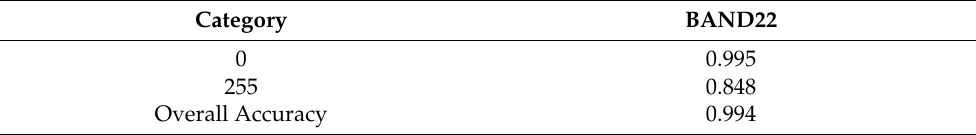
Table 17. Quantitative comparison results of metal sheets extraction from the Pavia university data